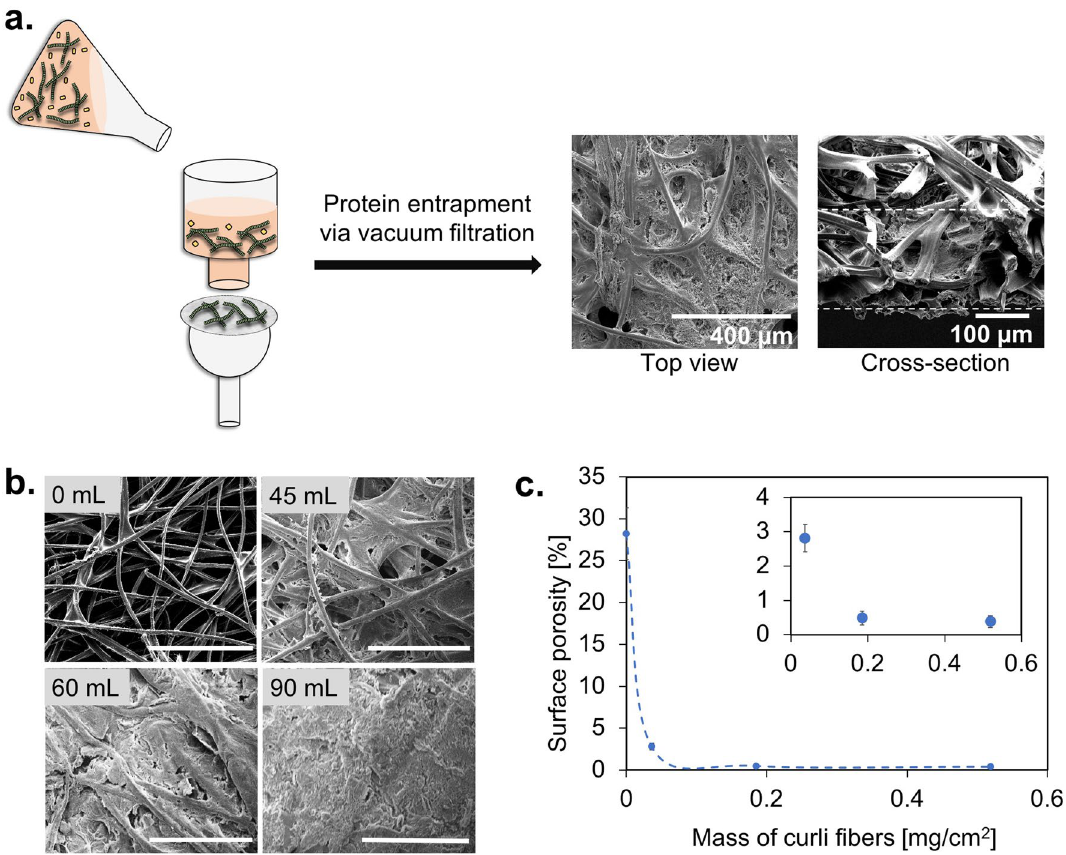
Figure 1. Integration of curli fibers with textiles via vacuum filtration. ( a ) A scheme of the vacuum filtration protocol adapted for textile–protein composite fabrication. ( b ) SEM images of textile–protein composites created using 0, 45, 60 and 90 mL of curli producing bacterial cultures. The protein content in the composites are 63 mg/cm 2 , 185 mg/cm 2 and 500 mg/cm 2 for 45, 60 and 90 mL of culture filtered, respectively. Scale bars: 300 µm. ( c ) Surface porosities of the different composites and acrylic control analyzed using ImageJ. Inset: Surface porosities of acrylic–curli composites only, excluding the acrylic control with high